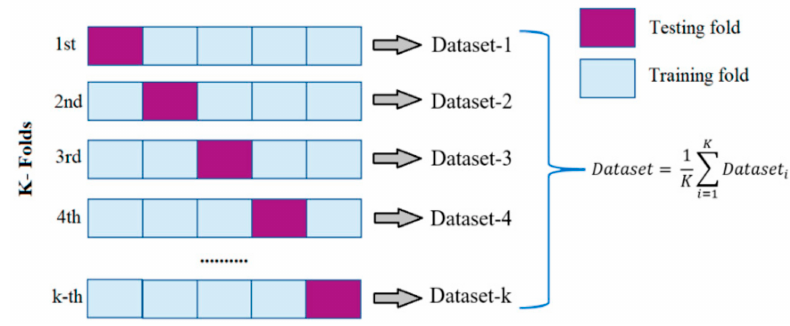
Figure 7. K-fold cross-validation with k